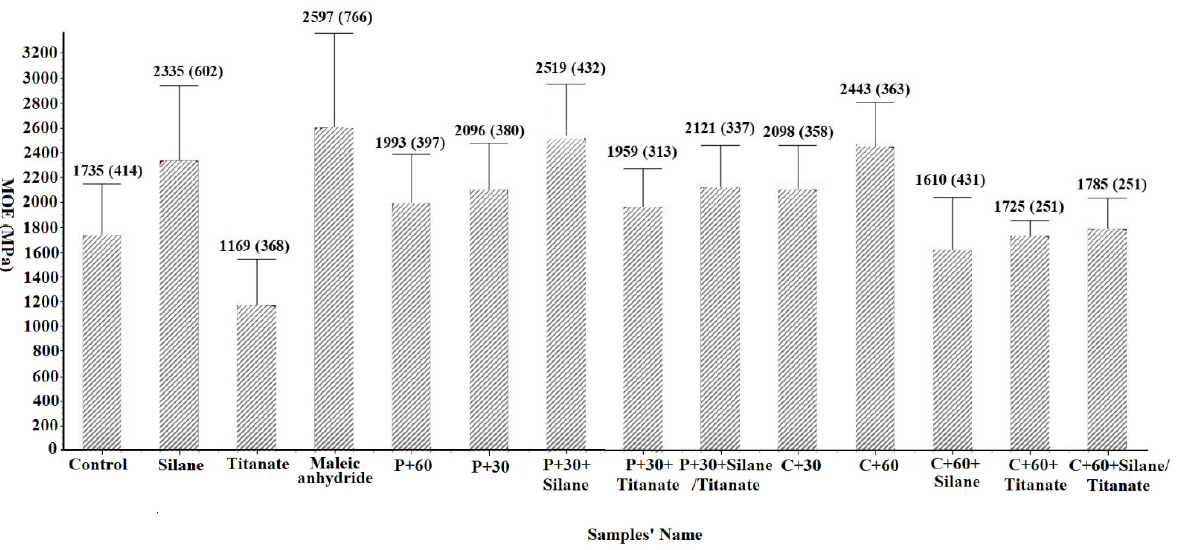
Figure 4. Elastic modulus of composites (MOE) (Values represent means of 10 replicates/test. Values in parentheses represent one standard deviation; the detail for samples’ name shown in Table 1).